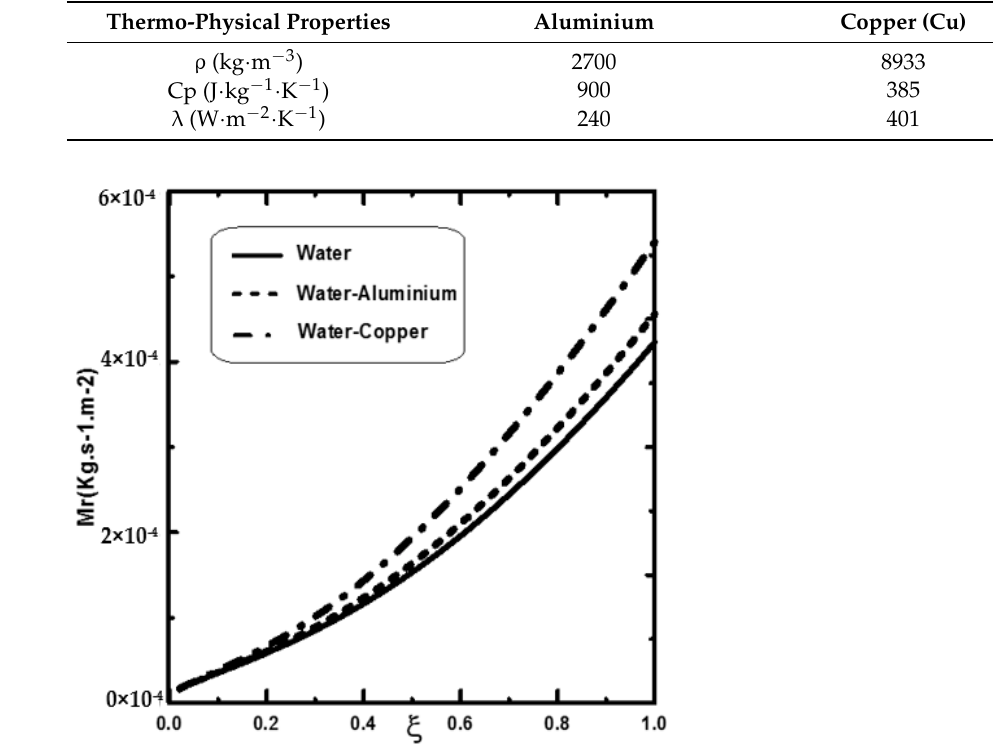
Figure 4. Effect of nanoparticles type on the latent ql ( a ) and sensible qs ( b ) heat fluxes: T 0 = 20 °C, T 0L = 20 °C, q 1 = 3000 W/m 2 , T w = 20 °C, c 0 = 0, u 0 = 1 m/s, m 0L = 15 × 10 − 4 Kg/m.s, p 0 = 1 atm, d/H = 0.015, φ 0 = 0.05. Table 2. Thermo-physical properties of the base fluid and of nanoparticles at T = 300 K.